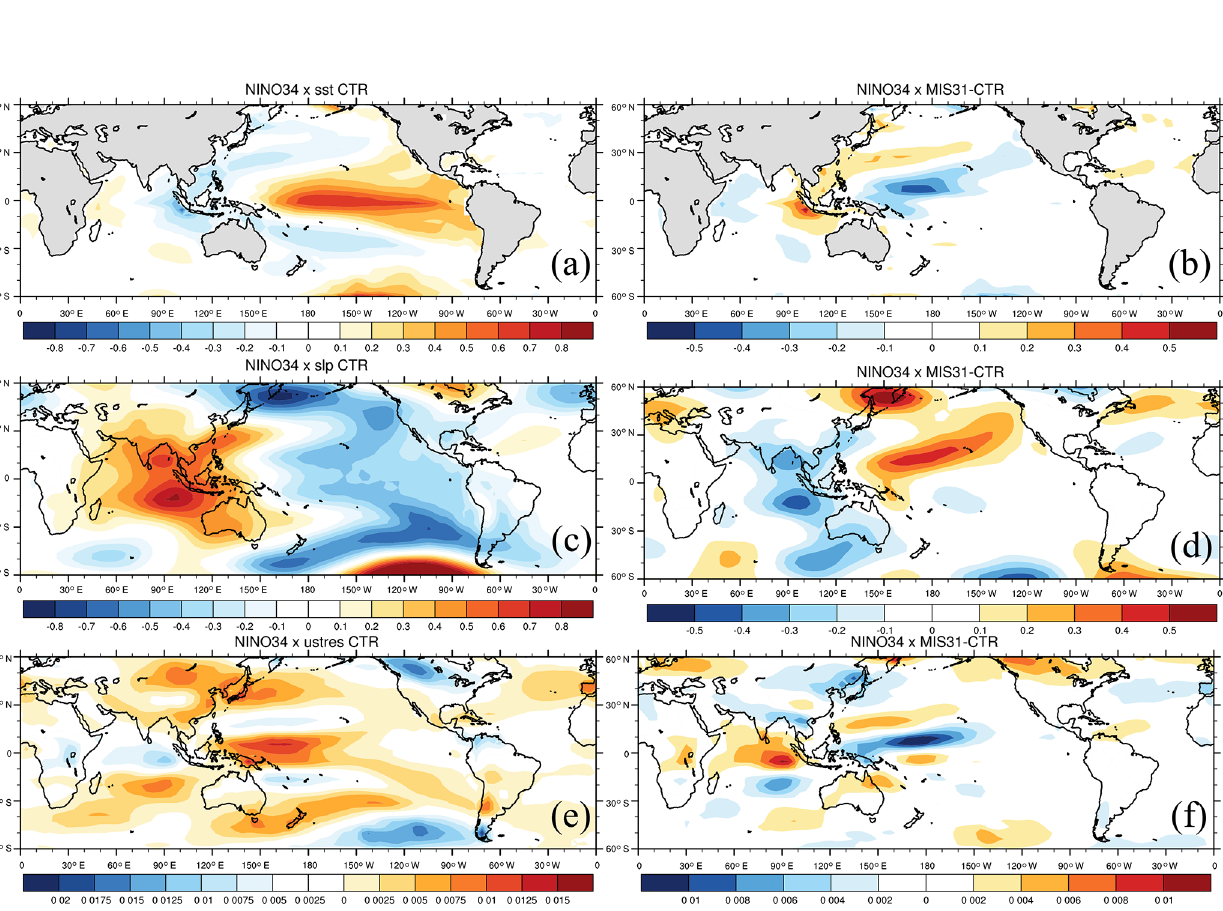
Figure 4. Panel (a) is the leading empirical orthogonal function (EOF) of SST anomalies for the CTR simulation displayed as amplitudes ( ◦ C) by regressing hemispheric SST anomalies upon the NIÑO34 time series. Panel (b) shows SST differences between the MIS31 and CTR regressed patterns. Panels (c) and (d) are as in (a) and (b) but for SLP (mbar). Panels (e) and (f) as in (a) and (b) but for zonal wind stress (Nm − 2 ). Please note that figures are shown with distinct